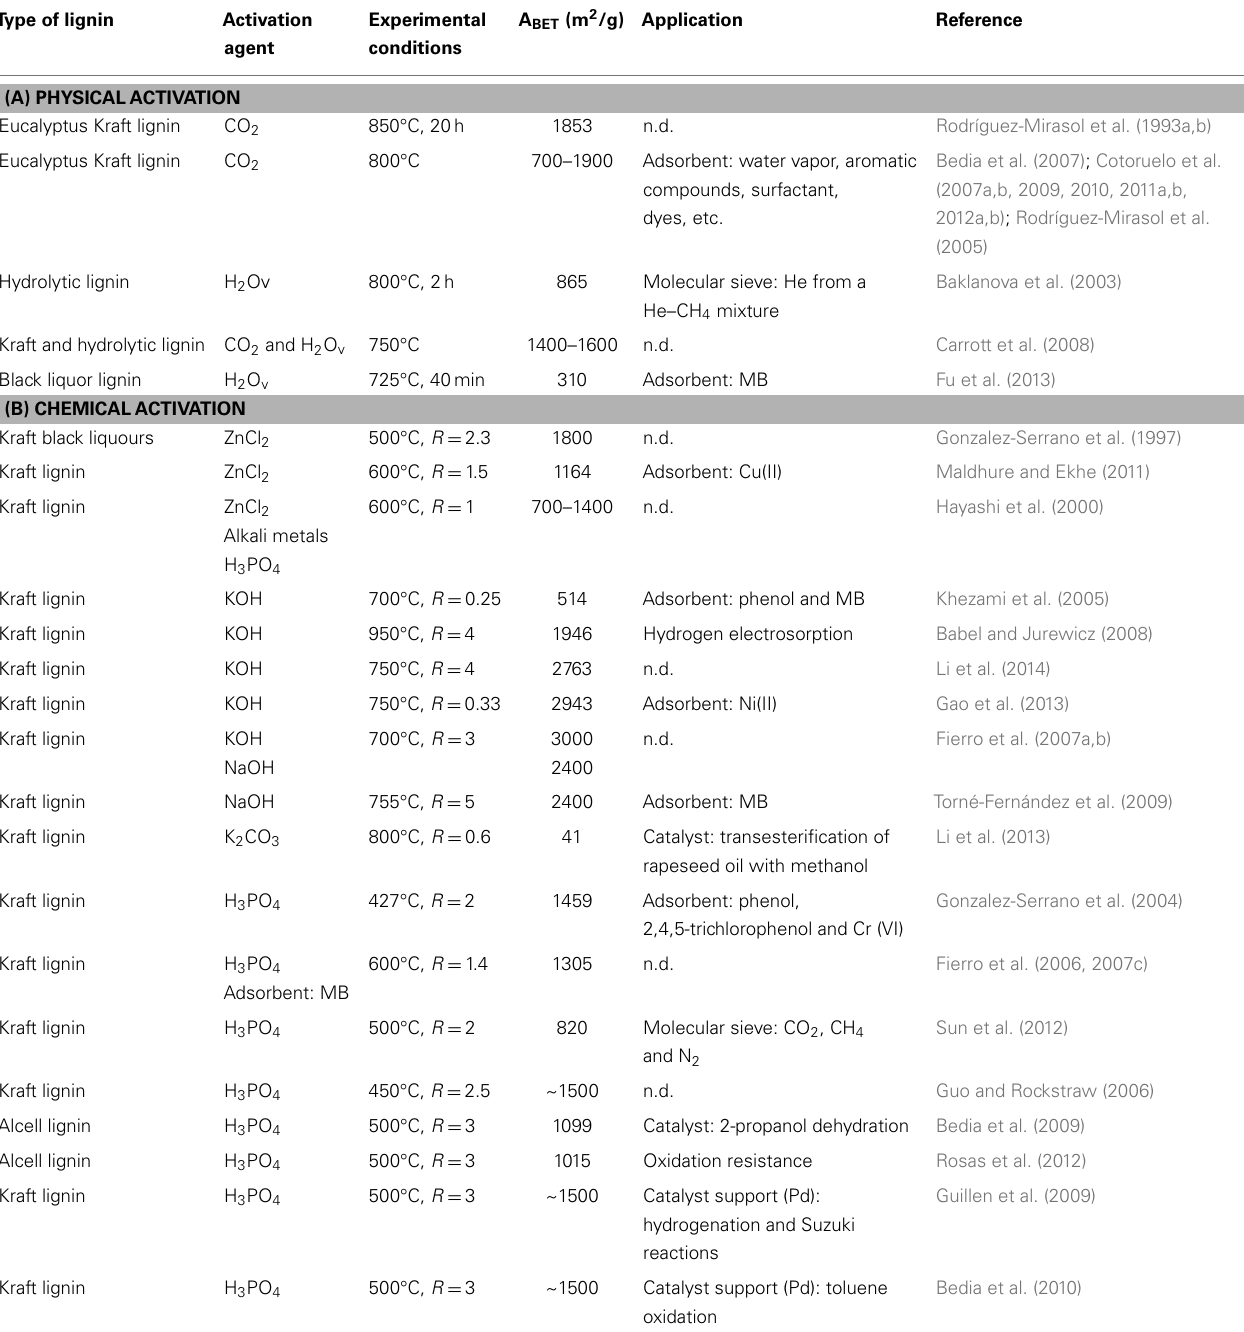
Table 1 | Experimental conditions, type of lignin, and application of activated carbons prepared from lignin (physical activation) and (chemical activation)